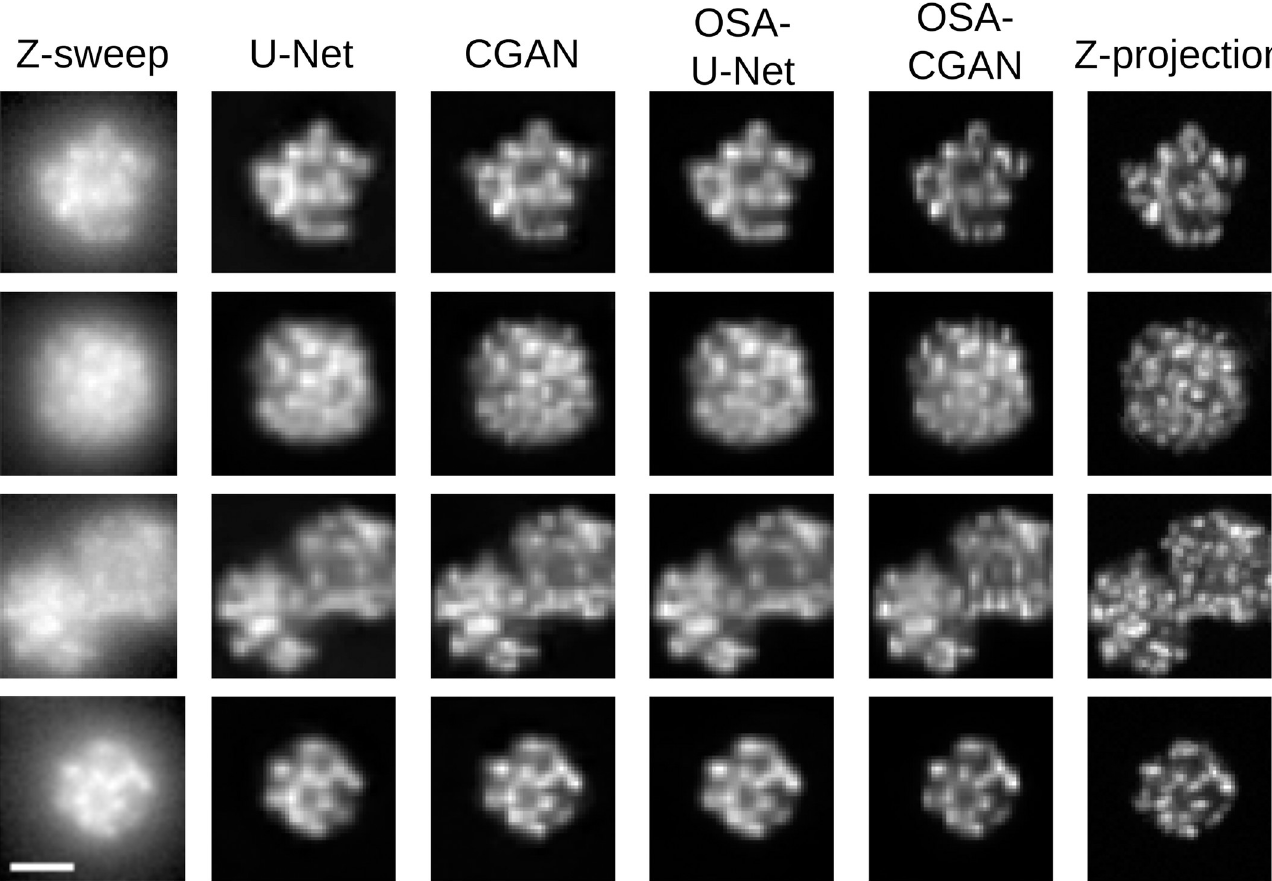
Fig 5. Illustrative examples of z-sweeps, z-projections and model predicted reconstructions for the compared models. The scale bar in the bottom left image is 50 μm and applies to all images. The brightness of the images are relative for visual purposes.